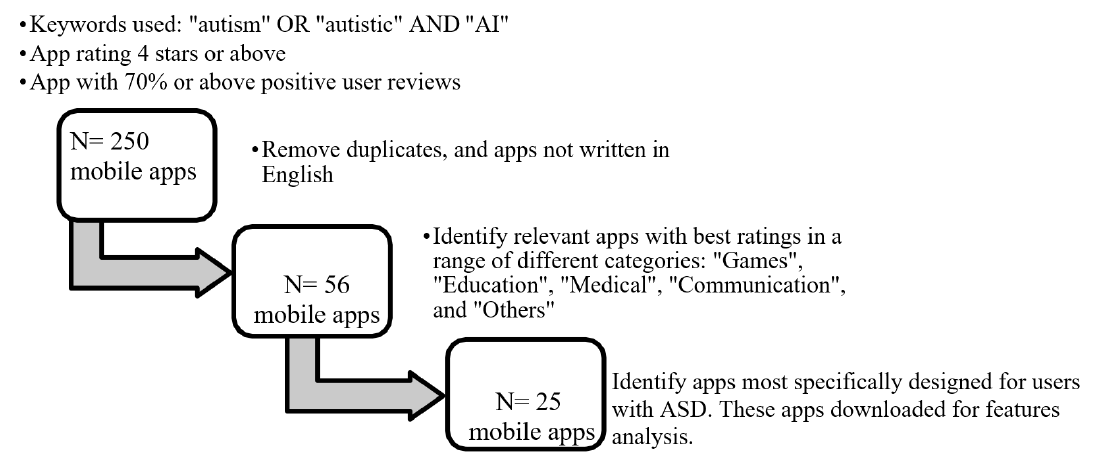
Figure 1. Mobile app selection